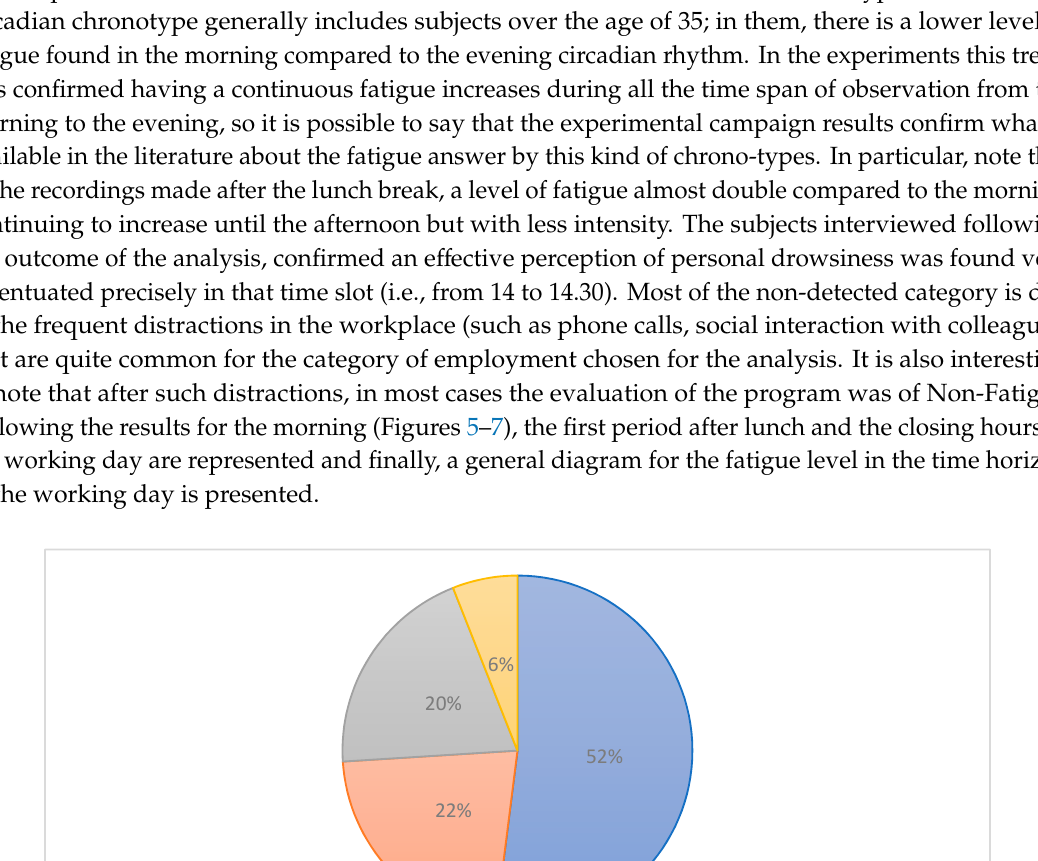
Figure 6. Results of the experiments in the first period after lunch for the morning circadian chrono- type.